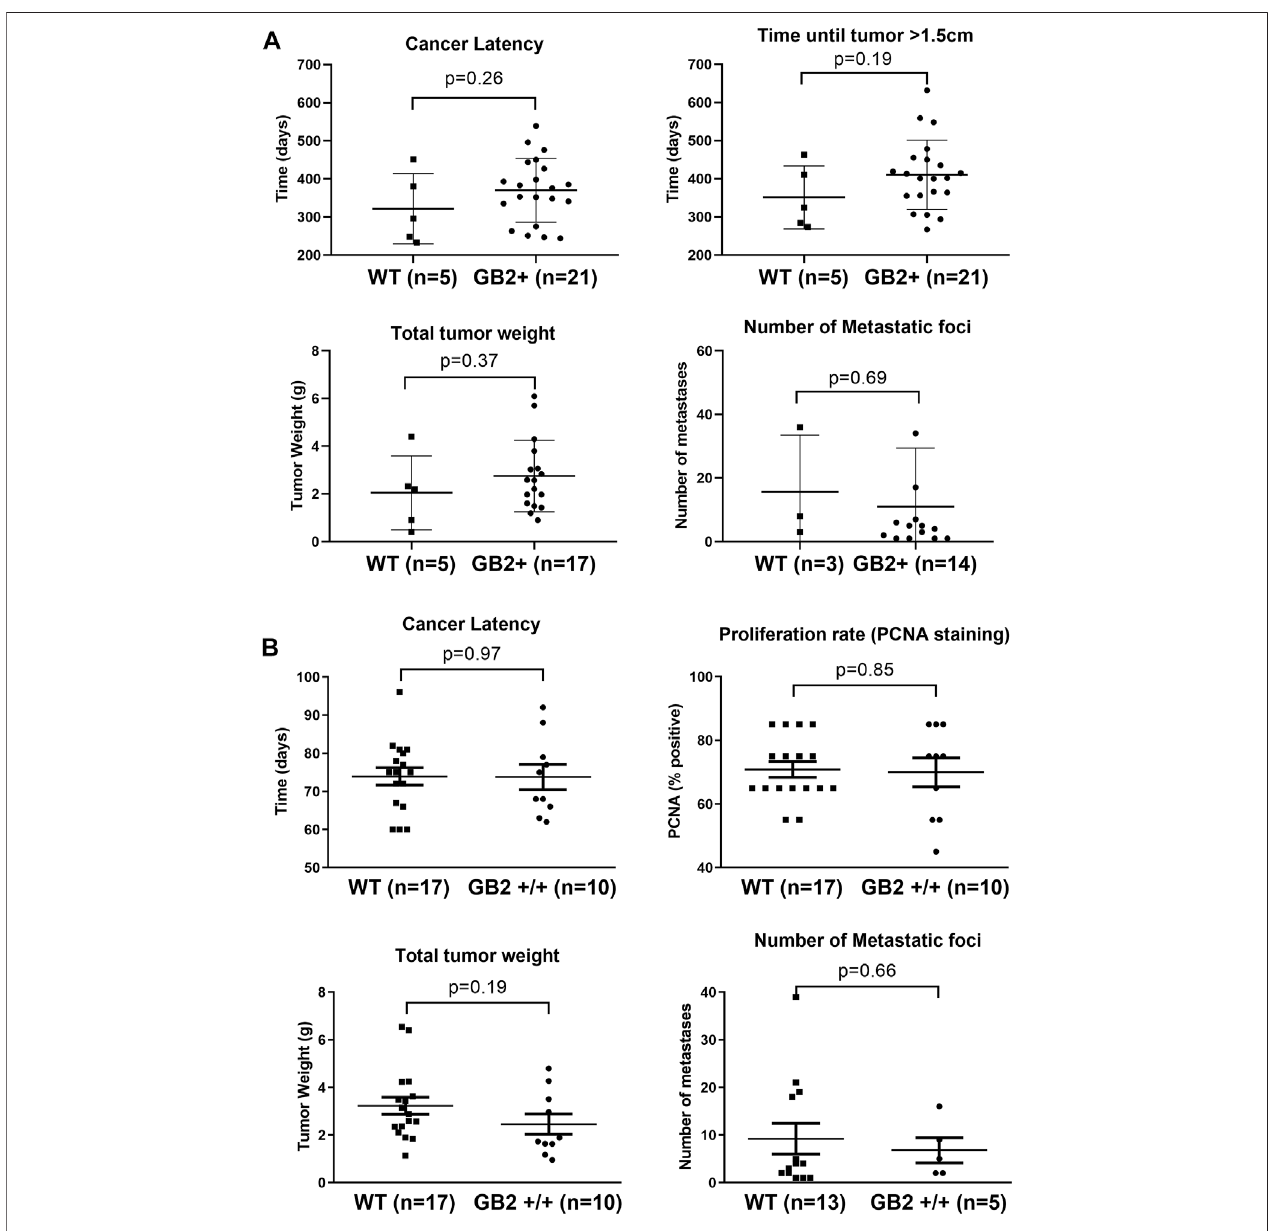
FIGURE6| Effect ofGSDMB2 onbreast cancergenerationand cancerprogressioninthe R26-GB2/MMTV-NEU andR26-GB2/MMTV-PyMTmouse models. (A) Comparisons between GB2+ (GB2+/+ and GB2+/-combined) and WT mice of the GB2/MMTV-NEU model (median age 15 months). All mice were heterozygous for HER2/NEU oncogene. (B) Comparisons between GB2+/+ and WT mice of the GB2/MMTV-PyMT model (15 weeks of age). All mice were heterozygous for PyMT oncogene.Tumorlatency:timeuntildetectionofpalpablemammarytumors.Totaltumorweight:Eachdatapointrepresentstheaddedweightofalltumorsforeach mouse.Proliferationrate:PercentageofPCNA-positivestaining(onlythebiggesttumorofeachmouse).Lungmetastasisfoci:numberofmetastaticlesions(onlyanimals with metastasis). Graphs show all data points, mean values (line) and standard deviations (error bars). Statistical differences were tested by Student ’ s t-test.